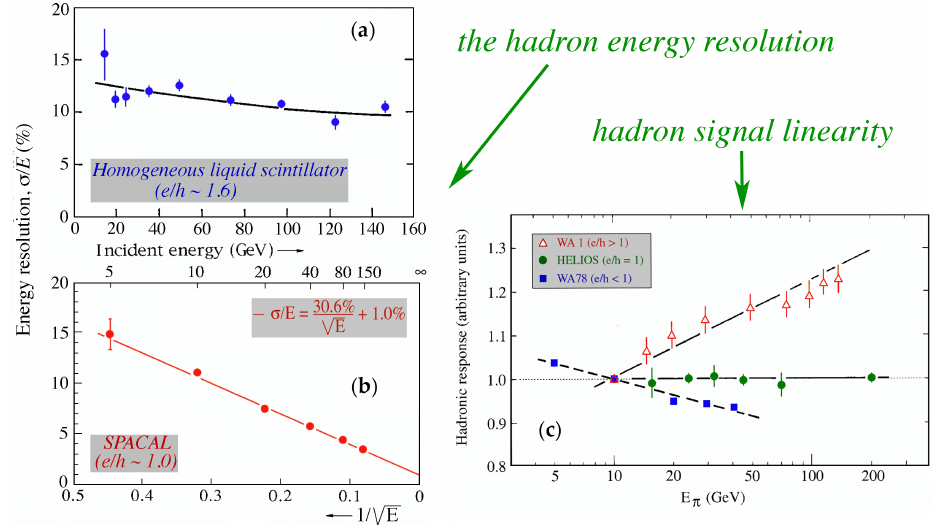
Figure 1. The effects of compensation for the performance of hadron